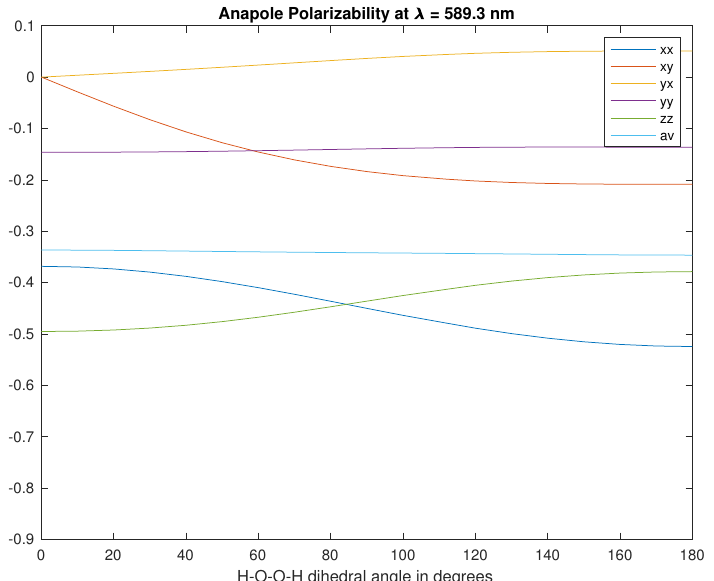
for the R α enantiomer of the hydrogen αβ